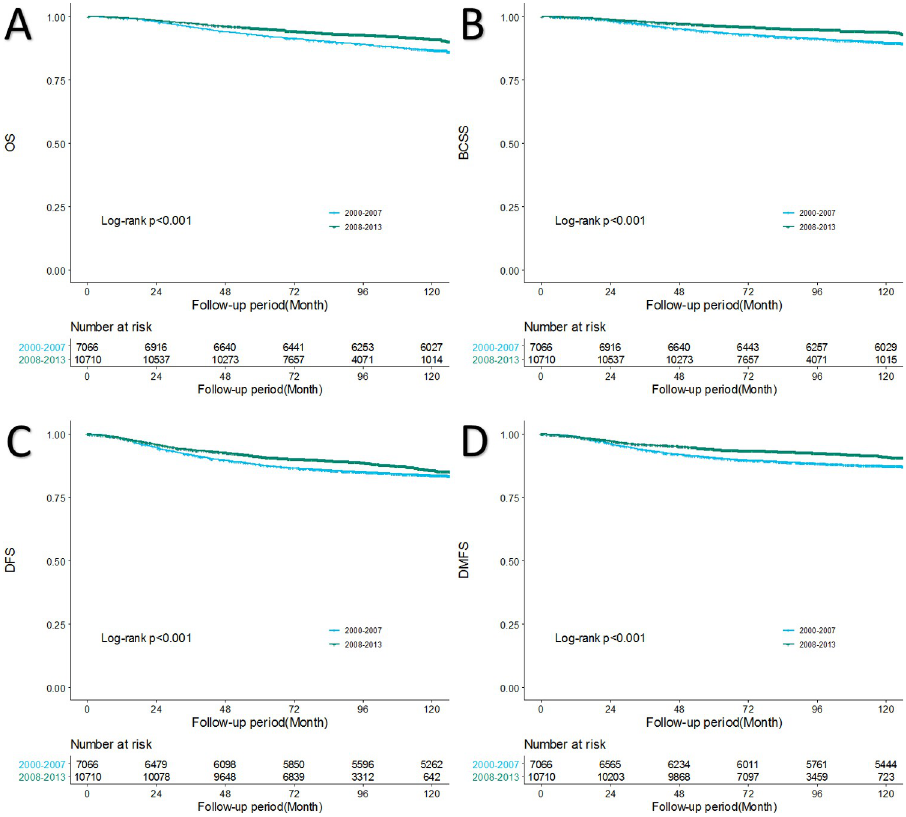
Fig 1. Chronological changes of survival in Korean breast cancer patients. (A) Overall survival (OS). (B) Breast cancer-specific survival (BCSS). (C) Disease-free survival (DFS). (D) Distant metastasis-free survival (DMFS).